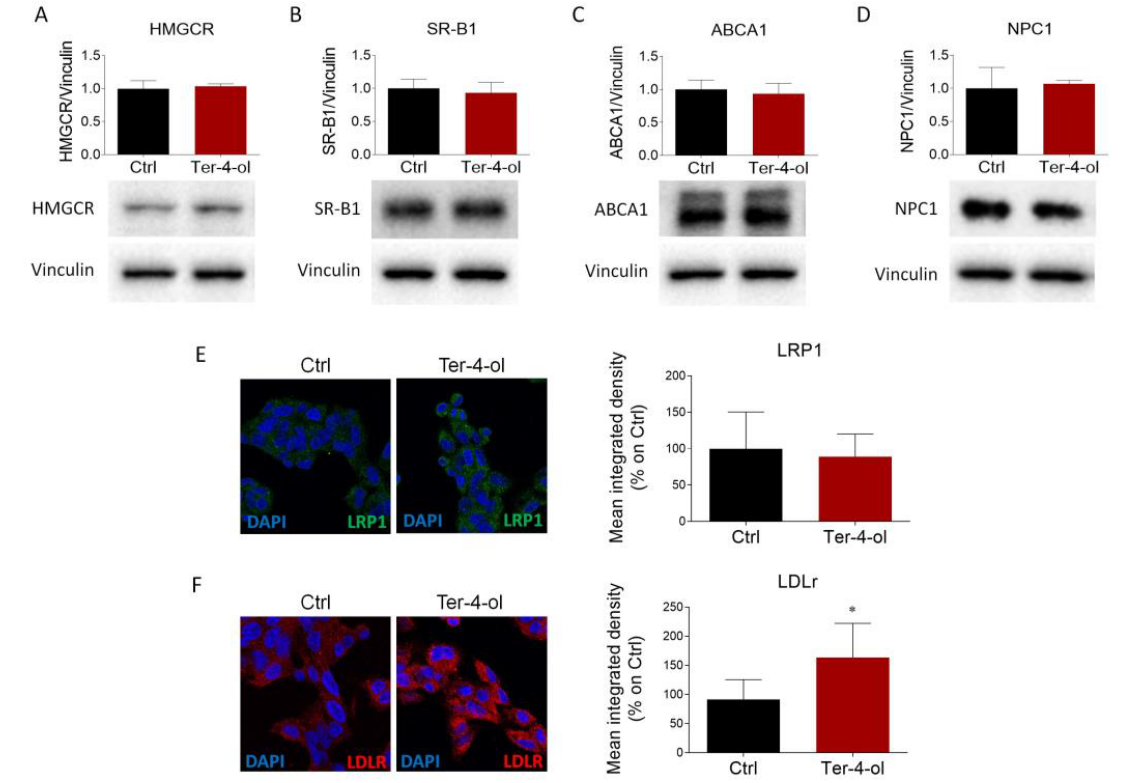
Figure 7. Effects of terpinen-4-ol on the main proteins that regulate cholesterol metabolism. ( A – D ). HepG2 cells were cultured in presence of vehicle (DMSO, Ctrl cells) or terpinen-4-ol (0.00034%) for 24 h and then evaluated by Western blot to assess HMGCR, SR-B1, ABCA1, and NPC1 protein ex- pression. Vinculin was used as the loading control. n = 3 independent experiments. ( E , F ) Immuno- fluorescence and confocal analysis (left panel) for LDLr (red) and LRP1 (green) proteins performed in HepG2 cells after vehicle (Ctrl) and terpinen-4-ol (0.00034%) administration for 24 h. DAPI (blue) was used to counterstain the nuclei. Graphs (right panel) represent the respective signal intensity quantification of both receptors. n = 6 different experiments. Data represent mean ± SD. Statistical analysis was assessed using the unpaired Student’s t -test. * p <